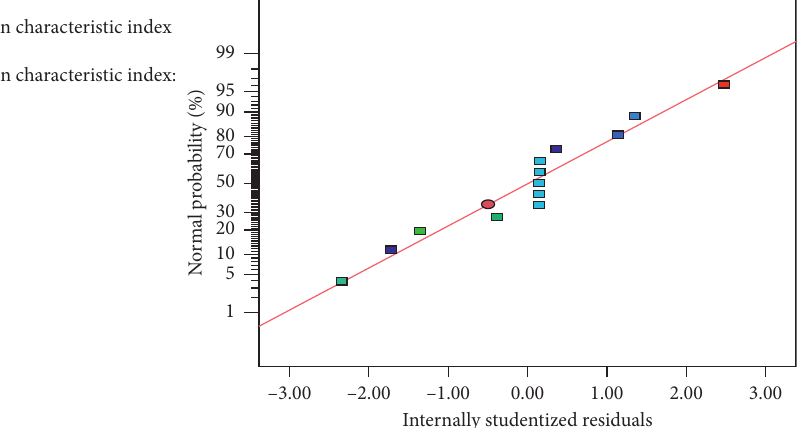
Figure 3: Distribution of the residuals of the combustible index.